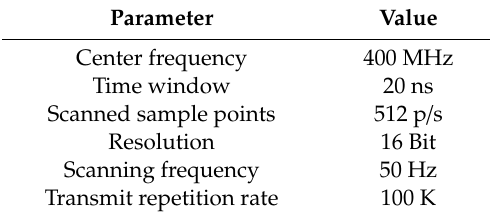
Figure 2. SIR-20 ground penetrating radar. Table 1. Experimental radar parameter table.